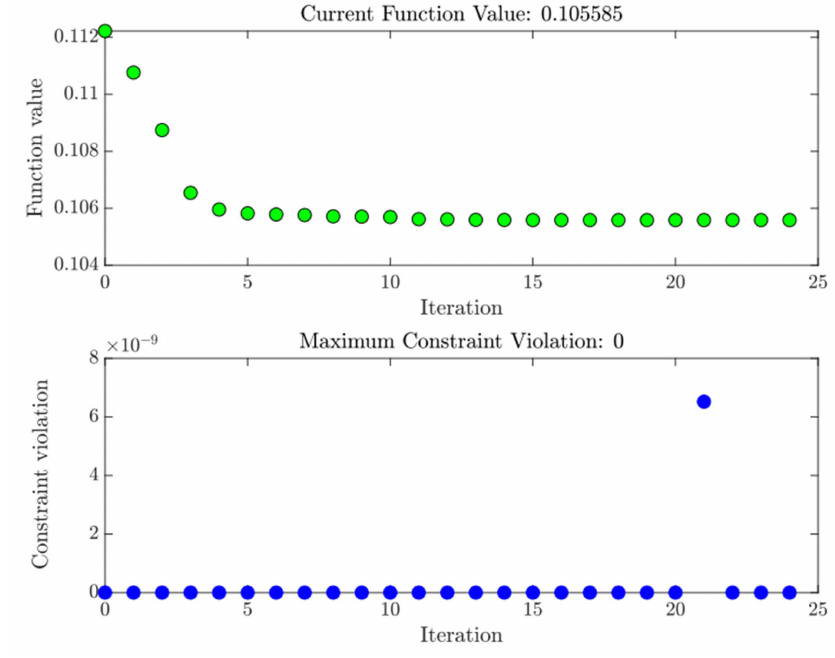
Figure 13. RBDO performance progress for Application